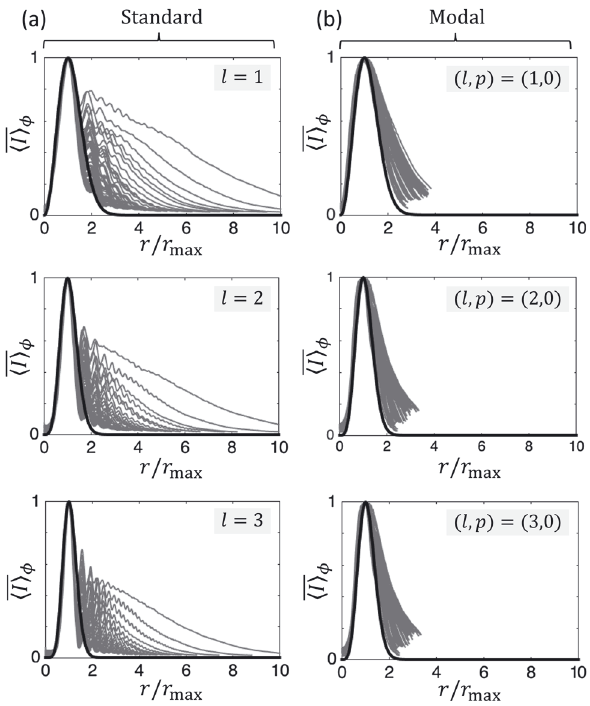
Figure 4: Reduced azimuth-average radial intensity distribution that corresponds to the data shown in Figure 3. We define = ⟨ I ⟩ ∕ max ⟨ I ⟩ [ ⟨ I ⟩ 𝜙 ] where r is the distance from the axis at 𝜙 𝜙 max r which ⟨ I ⟩ 𝜙 is maximum at a fixed z , for standard (a) and modal (b) vortex beam shapers with l = (1 , 2 , 3). Gray curves: experimental data. Black curves: propagation-invariant reduced Laguerre–Gauss √ 2 ∕ | l | ) 2 | l | exp (1 − 2 𝜌 2 ) where 𝜌 = r ∕ r profiles ( 𝜌 max